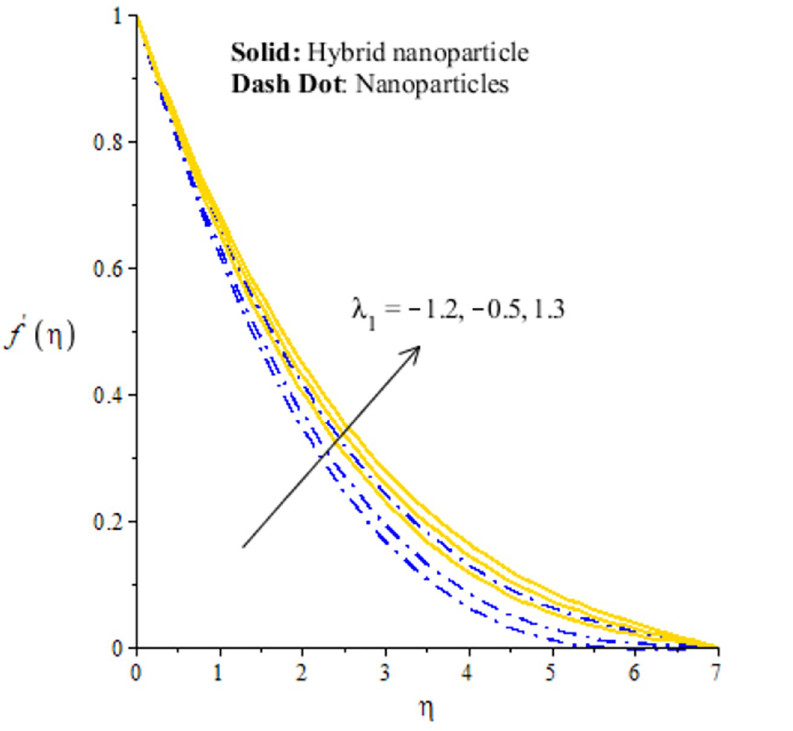
Fig 5. Distribution of velocity versus λ 1